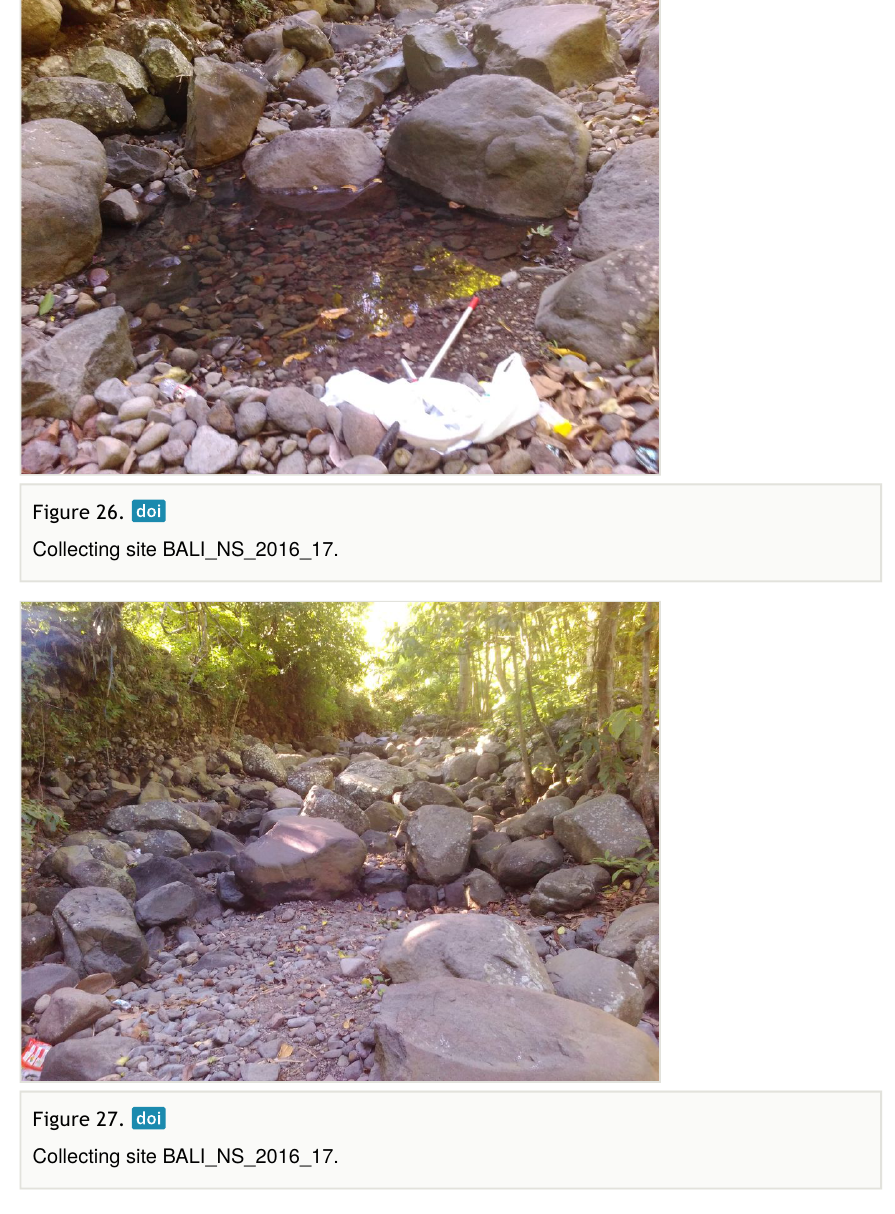
Collecting site